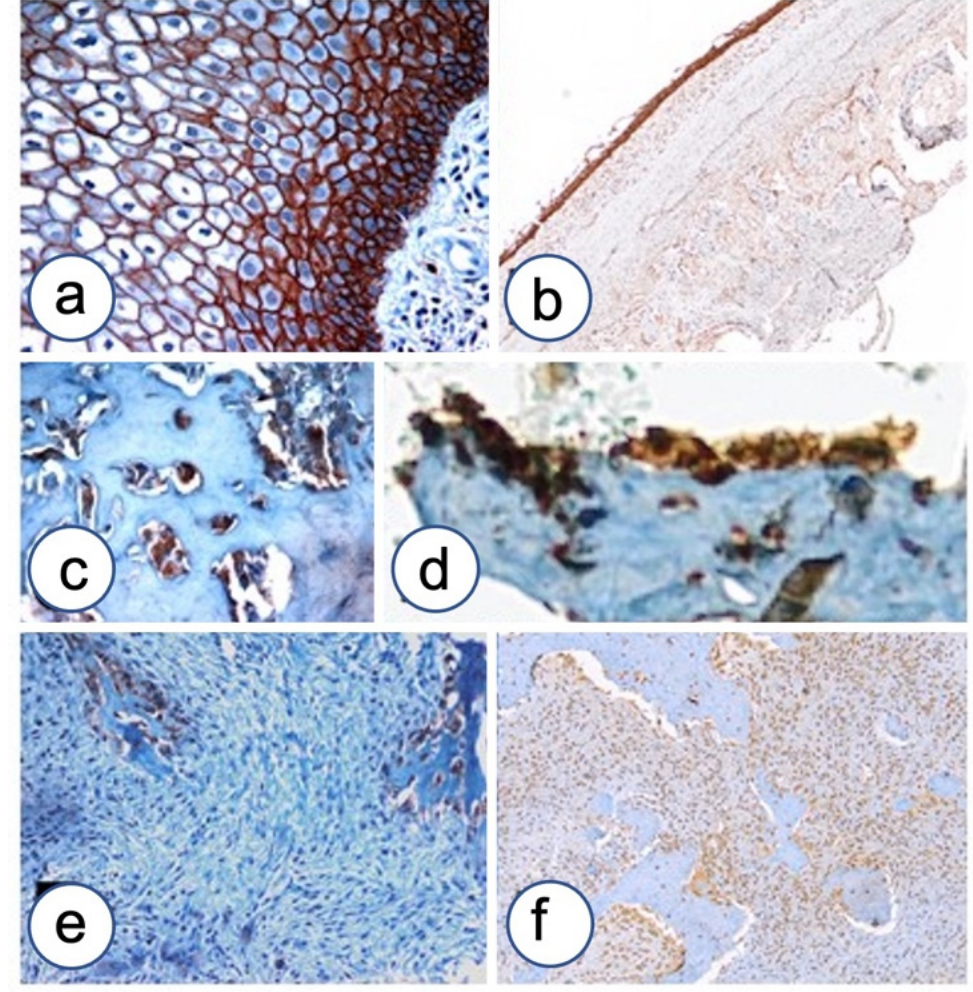
Figure 4. N-cadherin upregulation in FD. ( a ) Positive control for N-cadherin staining in oral epithe- lium. ( b ) N-cadherin staining in epithelium of developmental odontogenic cyst and surrounding remodeling bone. ( c ) N-cadherin over-expression in osteoblasts lining osteoid in a case of pagetoid- type FD. ( d ) Magnification of osteoblasts expressing N-cadherin in FD. ( e ) A case of FD showing N-cadherin selectively expressed in osteoblasts without any expression in fibroblastoid cells. ( f ) A case of FD showing N-cadherin over-expression in fibroblastoid cells committed to inefficient osteoblast differentiation. Magnifications, × 4 ( b , c ), × 10 ( e , f ), × 20 ( a , d ). OB-cadherin stained medullar precursors committed toward osteoblast differentiation and terminally differentiated osteoblasts in bone controls, while it stained negative in seven out of eight cases of FD analyzed. It was weakly expressed only in one case with the Chinese alphabet pattern (Figure 5). P-cadherin showed over-expression in pagetoid/hyper- cellulated FD, confined to osteoblasts, while a negative staining was observed in the fibrous area of FD without osteoid formation (Figure 6). Weak expression was also detected in a case of FD with the Chinese alphabet pattern. The E-cadherin antibody stained negative in all pathological cases examined, and the comparison with normal bone controls resulted statistically significant ( p < 0.05) (Figure 6). Finally, P-Runx2 also showed over-expression in six out of eight cases of FD, both in fibroblastic stroma and in retracted osteoblasts (Figure